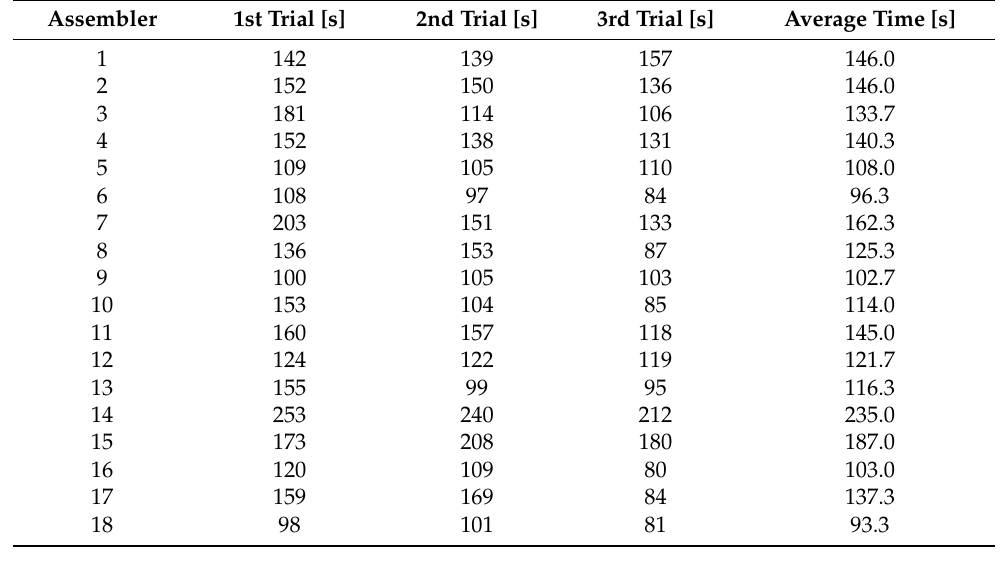
Table 4. Assembly time using original instructions.